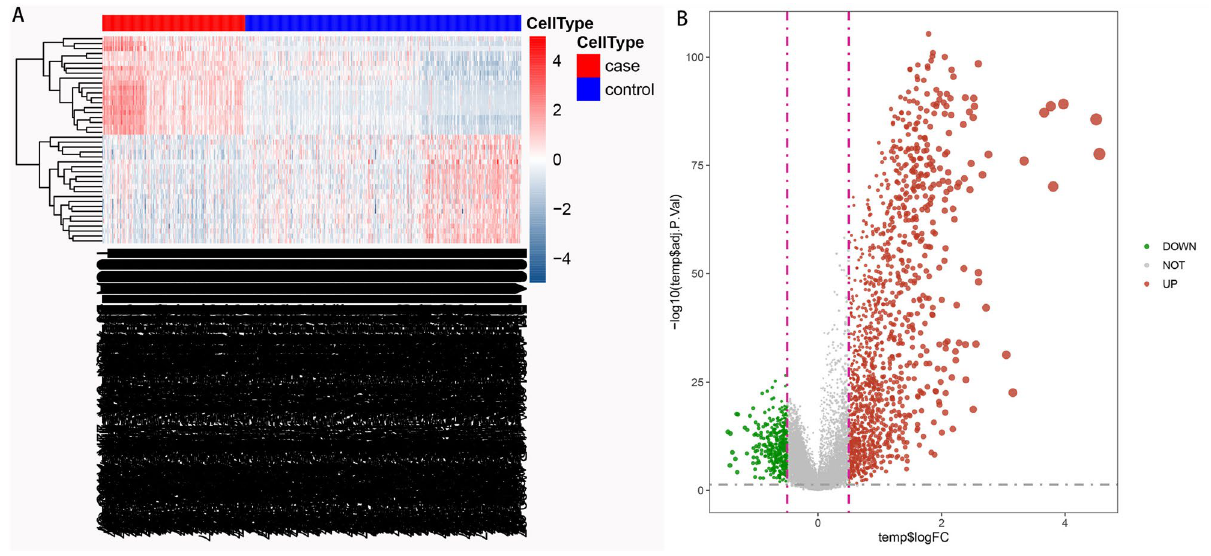
Figure 6. Differences in immune cell types and differentially expressed genes in cold and hot tumors. ( A ) The different immune cell types in cancer and adjacent tissue samples. ( B ) The up-regulation and down-regulation of differentially expressed genes in cold and hot